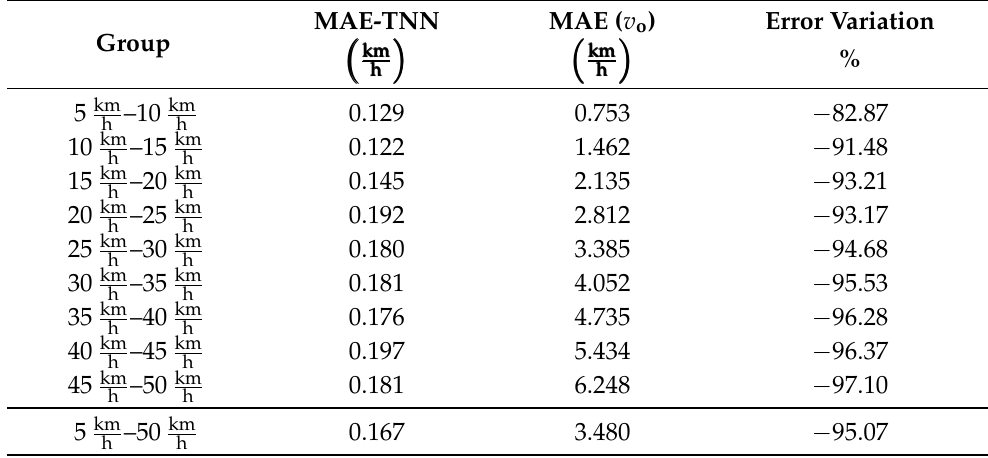
Table 5. MAE for the OBD vs. reference sensor comparison and the MAE for the inference of the TNN vs. reference sensor comparison. Database size: 603,828.